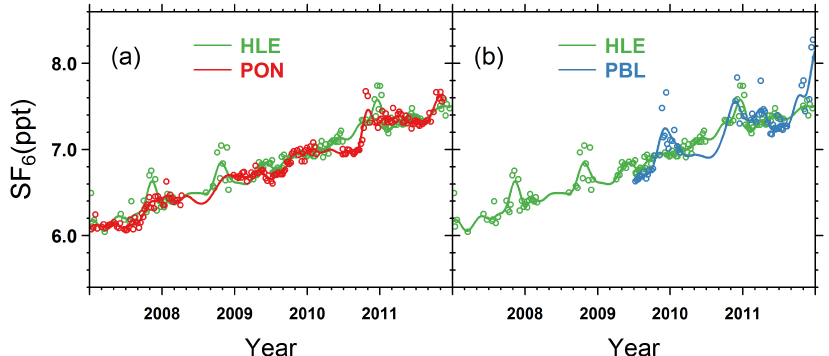
Figure 8. Time series of SF 6 flask measurements at (a) HLE and PON and (b) HLE and PBL. The open circles denote flask data used to fit the smoothed curves. For each station, the smoothed curve is fitted using Thoning’s method (Thoning et al., 1989) after removing outliers.